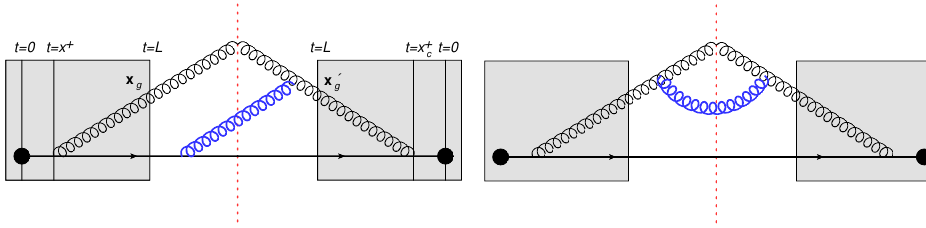
Figure 2 . Left: the interference diagram M q M † computed in this paper with the soft gluon g highlighted in blue. The remaining gluon leg is referred in the text as BDMPS-Z gluon. Right: the direct diagram M g M † that is not directly computed since it is proportional to the BDMPS- g Z result. On the left hand side we have explicitly indicated all the time intervals present in the problem, with the emission time not matching in the amplitude ( x + ) and its complex-conjugate ( x + ). The medium is assumed to be static and homogeneous of length L , and the initiating quark is c produced in a hard process (black blob) at time t = t 0 = 0 in both amplitude and complex-conjugate amplitude. Note that the initial hard process can be factorized from the rest of the diagram and is henceforth